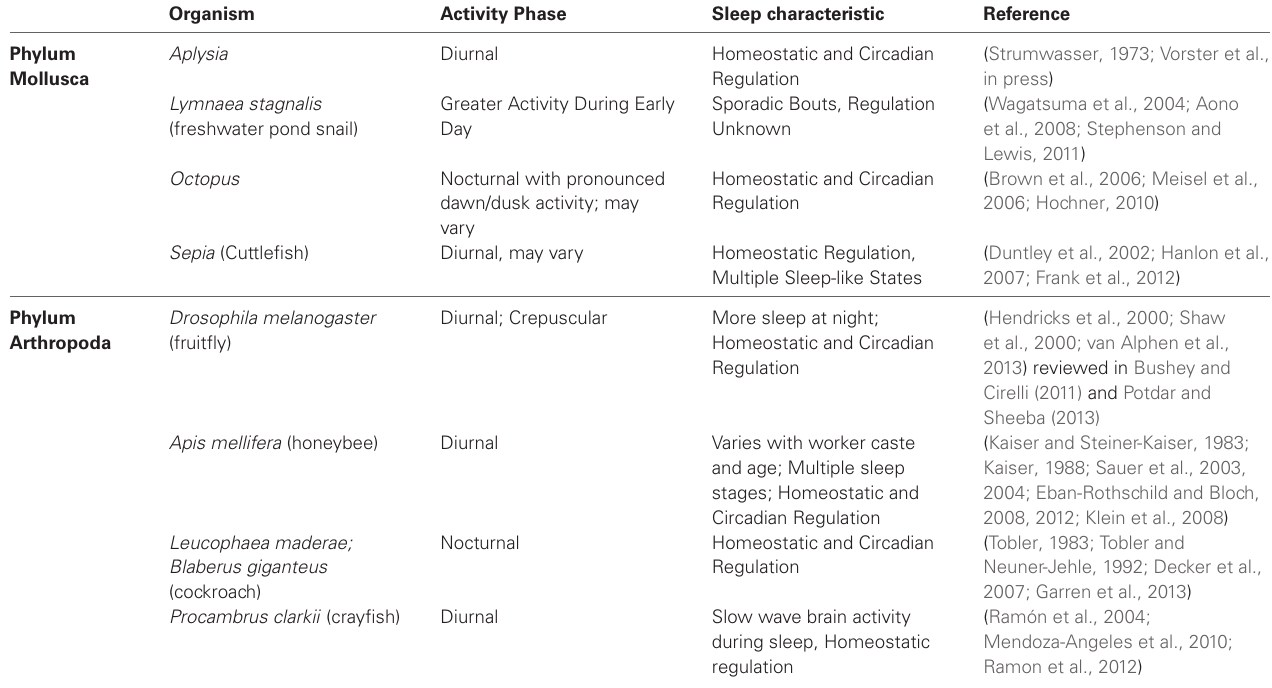
Table 1 | Examples of invertebrate species from the Phyla Mollusca and Arthropoda in which sleep has been studied